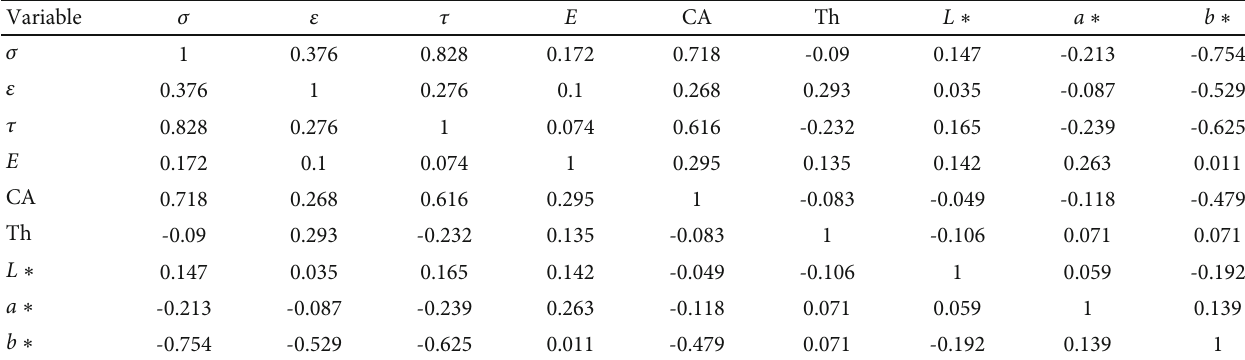
Table 8: Coe ffi cient matrix of aged PVDF-coated fabrics (group 1).